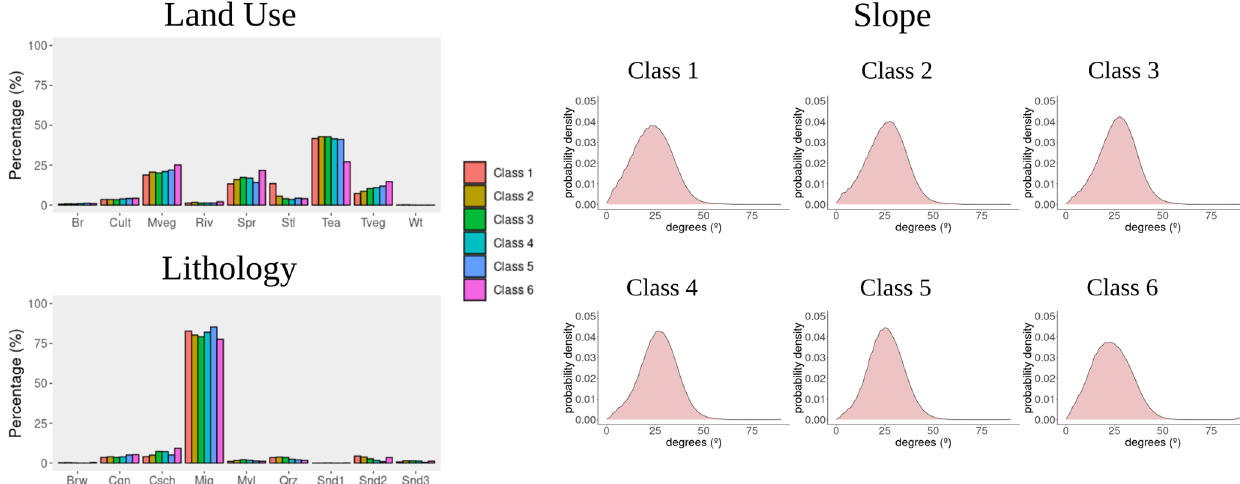
Figure 5. Slope probability density plots and land use and lithology distribution by SA classes for Darjeeling study areas. Land use types are Br: barren; Cult: cultivated land; Mveg: moderate vegetation; Riv: river; Spr: sparse vegetation; Stl: settlement; Tea: tea plantation; Tveg: thick vegetation; Wt: water body. The lithology types are Brw: brownish, yellow oxidised soil with boulders or pebbles and latsol; Cgn: calc granulite, quartzite, gneiss, gar, sil, kya schists; Csch: chlorite sericite schist and quartzite, metagraywacke; Mig: banded migmatite, Gt–Bt gneiss, mica schist, biotite gneiss; Myl: mylonitic granite gneiss; Qrz: quartz arenite, black slate, cherty phyllite, quartzite; Snd1: sand,